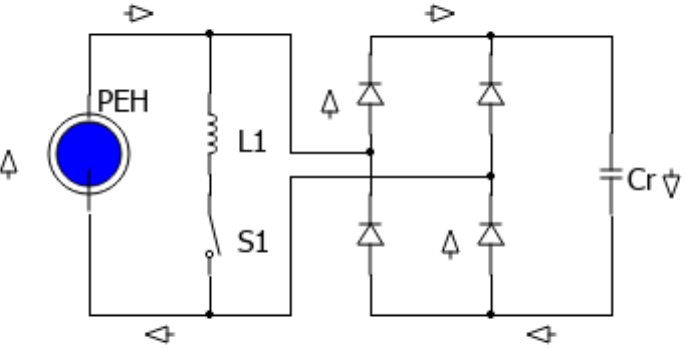
Figure 6. Schematic of P-SSHI energy extraction interface.